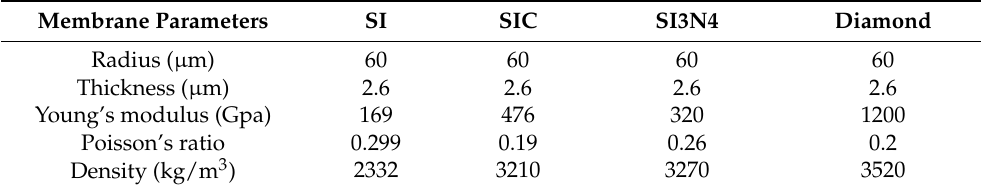
Table 1. Performance parameters of different membrane materials.